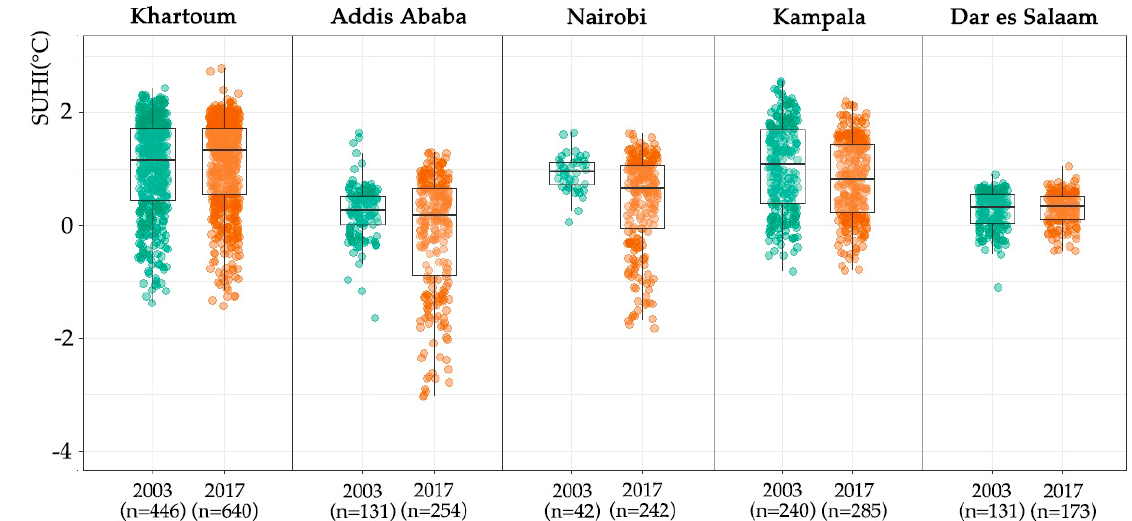
Figure 5. Night-time SUHI value distributions for each city in 2003 and 2017. The boxplots show the distribution of night-